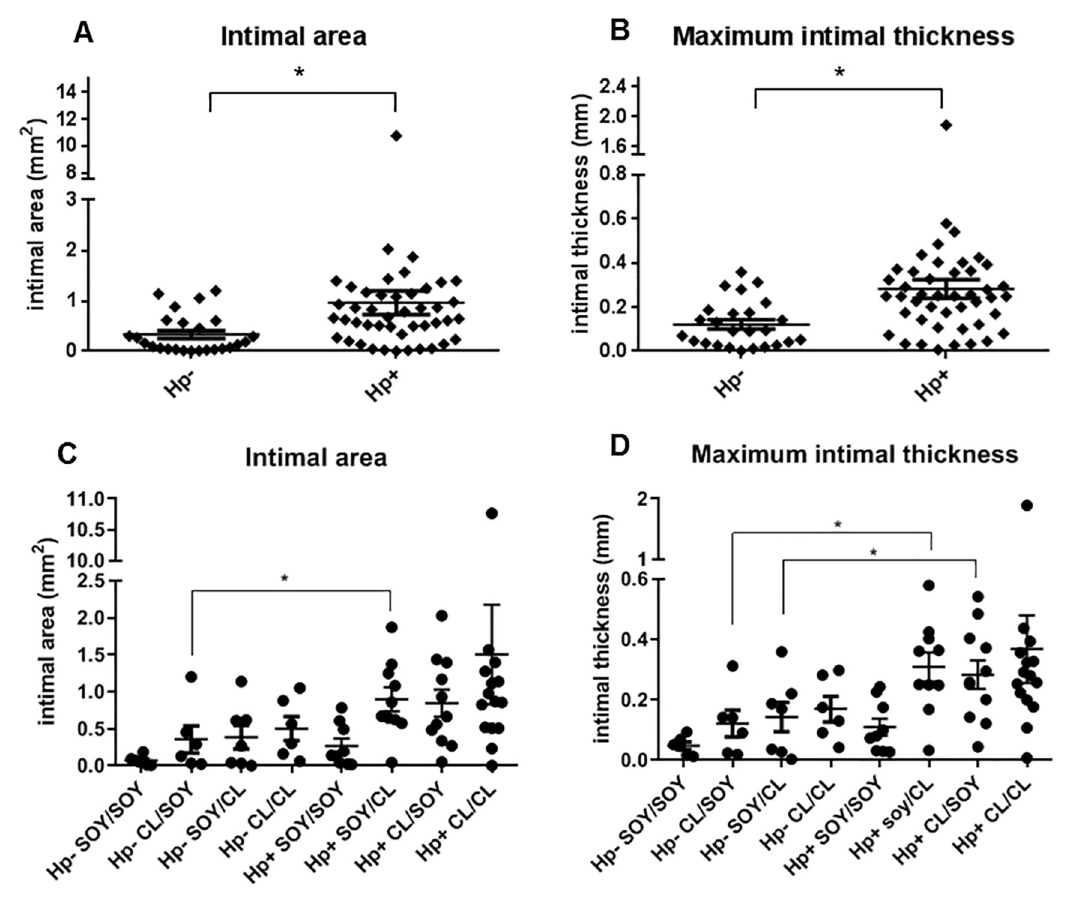
Fig 10. Effects of H . pylori infection and diet on coronary artery plaque measurements. The values shown represent the average plaque measurements of the left circumflex, left anterior descending, and right coronary arteries. Values are grouped according to H . pylori (Hp) status (A and B) or according to H . pylori status and pre/postmenopausal diet group (C and D). Graphs show mean +/- standard error of the mean. � P < 0.05. https://doi.org/10.1371/journal.pone.0222001.g010 Table 3. Correlations between plaque measurements and H . pylori density in the artery or stomach. artery 16S artery cagA stomach 16S stomach cagA P value Corr. P value Corr. P value Corr. P value